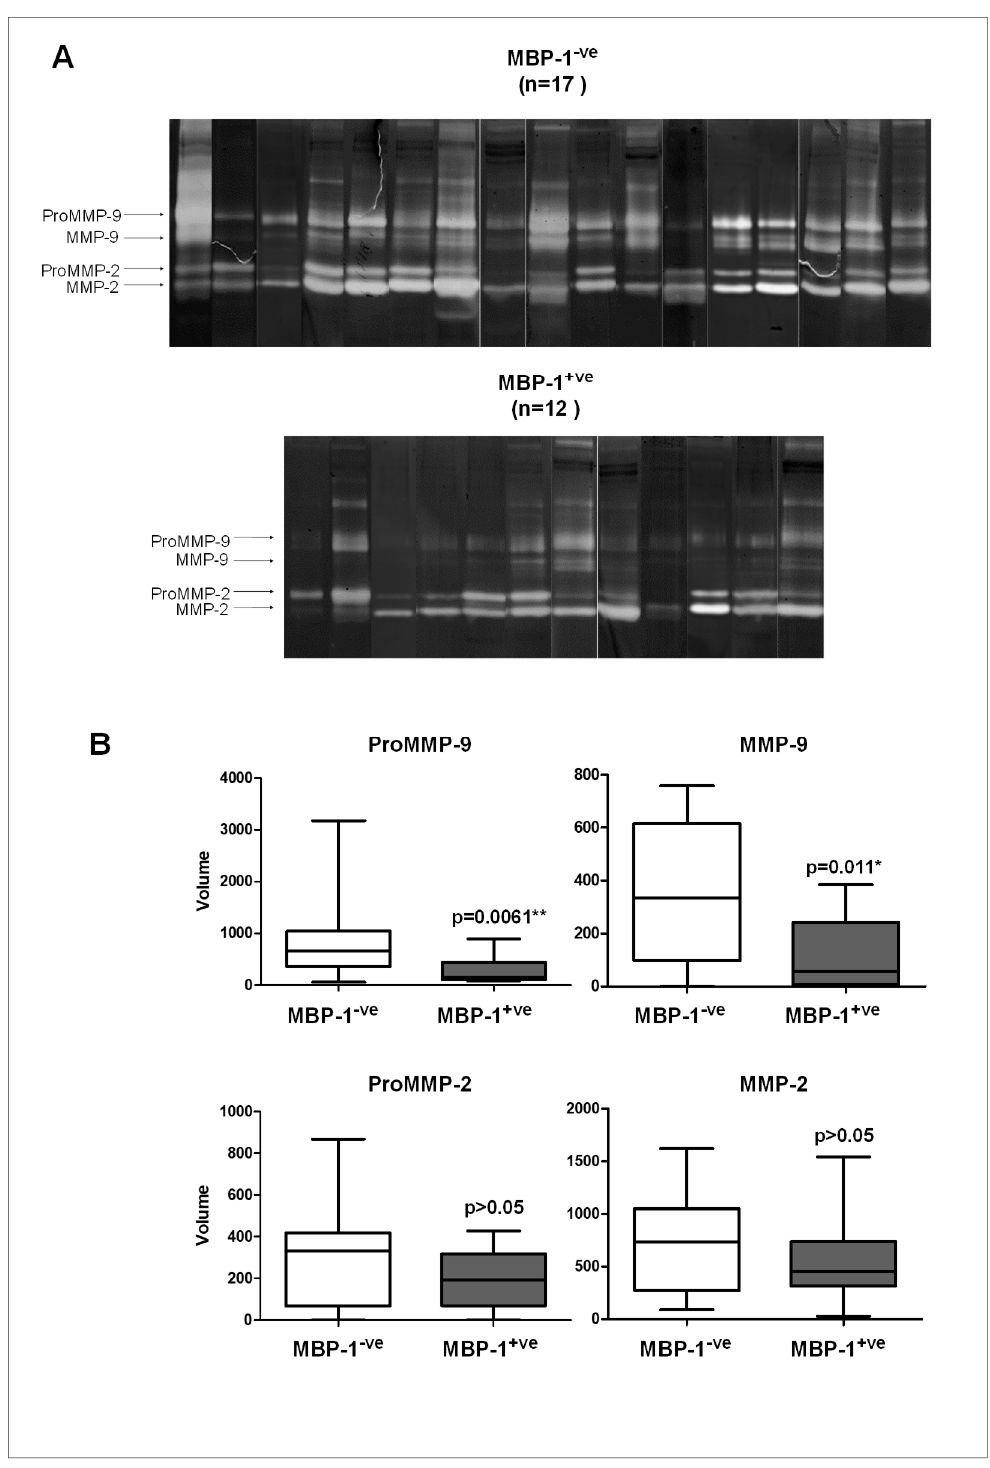
Figure 4. Matrix metalloproteinases (MMP)-9 and MMP-2 activity levels in breast cancer tissues according to MBP-1 expression. ( A ) Gelatin zymography of 29 breast cancer patients split into two groups (MBP-1 -ve and MBP-1 +ve ) according to the MBP-1 expression. ( B ) Quantification of lytic bands. Each data point is the average of three independent experiments. Error bars represent standard deviation and p values indicate statistical significance.